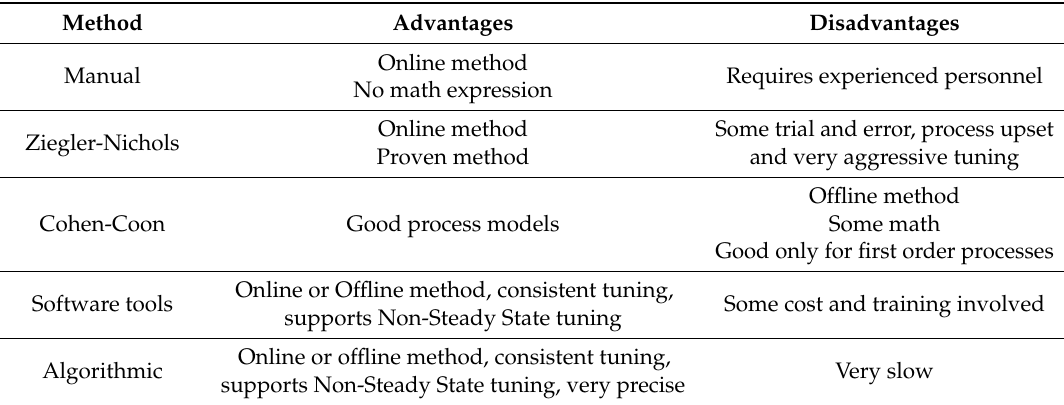
Table 2. Methods of adjusting the gain of a PI